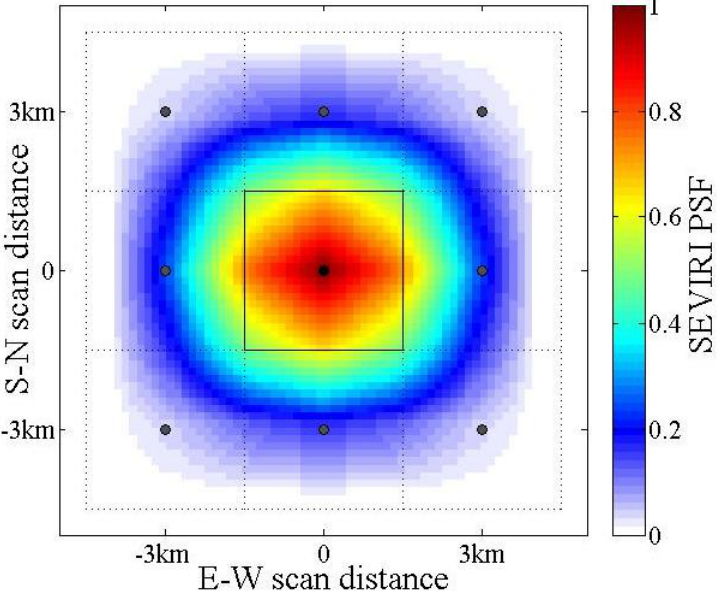
Figure 4. SEVIRI pixel boundaries (solid and dashed lines) are drawn at a distance halfway between adjacent pixel centres (filled circles). These artificial boundaries do not coincide with the orientation and overlap of SEVIRI’s point spread function (PSF), which is shown for the centre pixel located at the sub-satellite